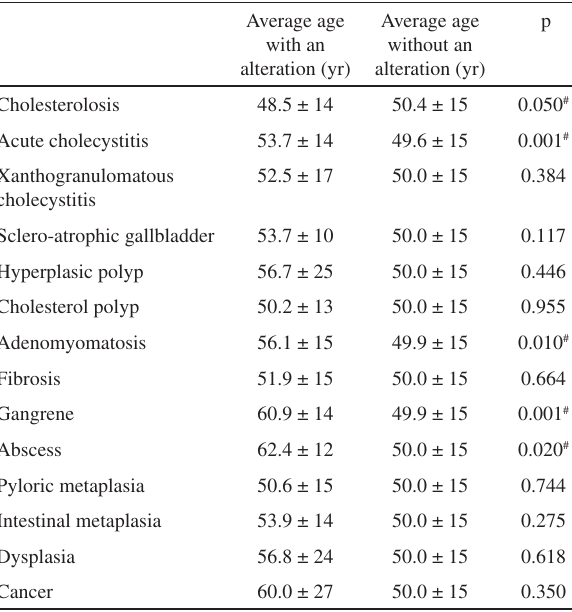
Table 6 - Analysis of the histological alterations